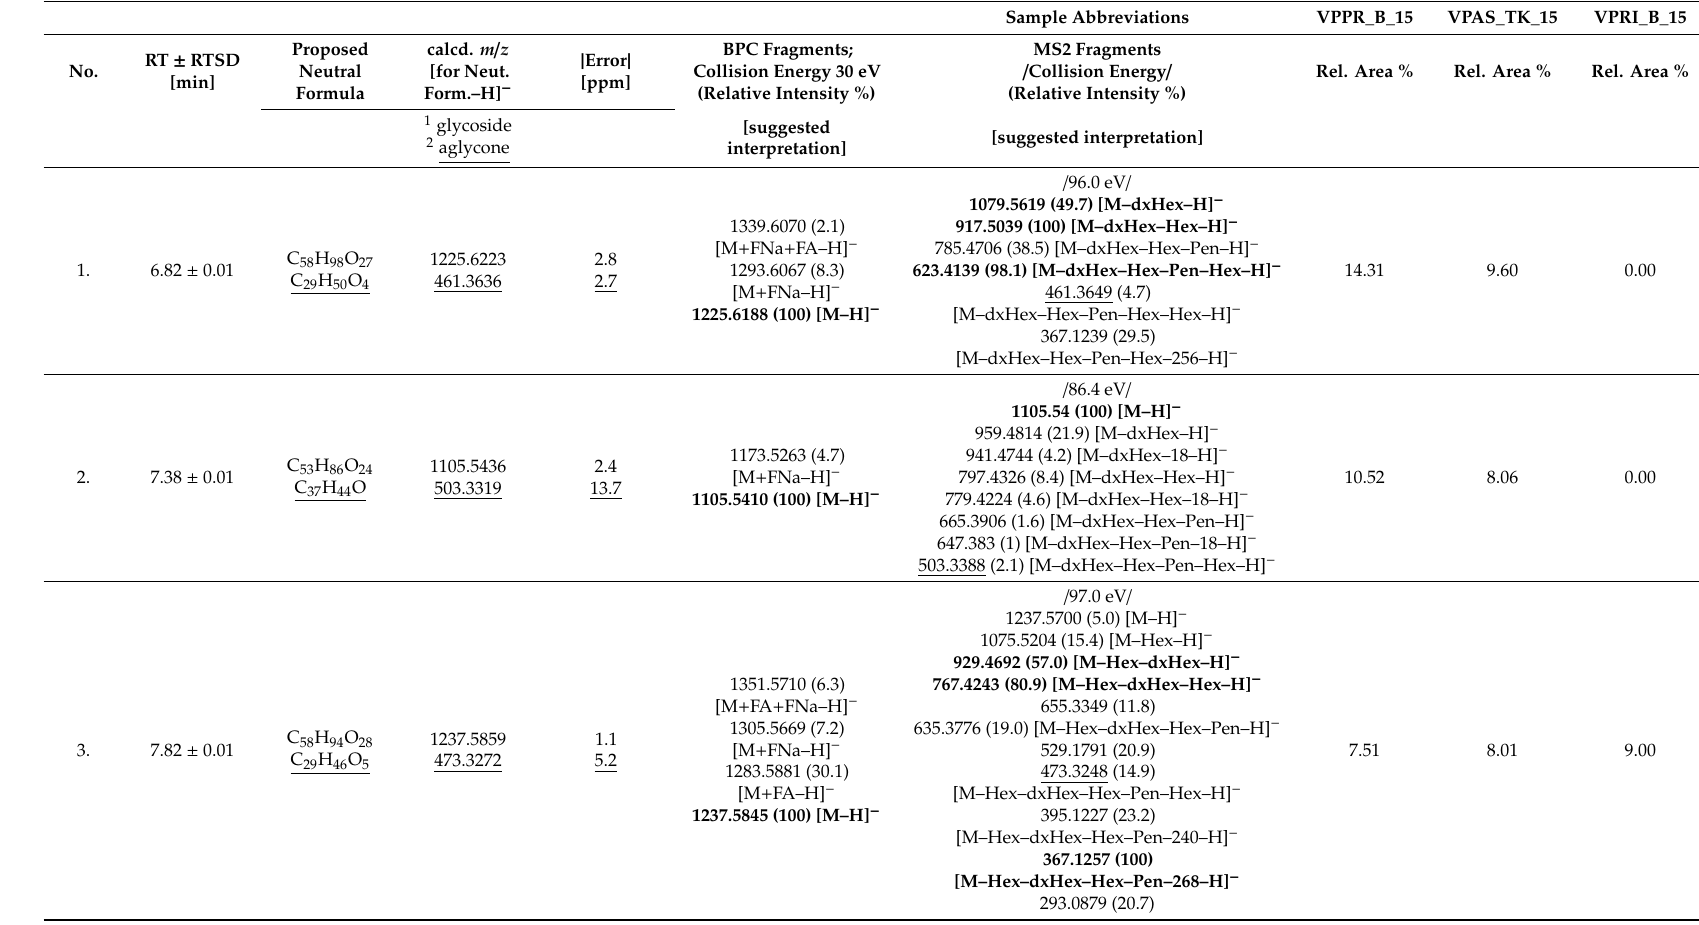
Table A2. UHPLC-MS and detailed -MS / MS results for Vitaliana primulifora